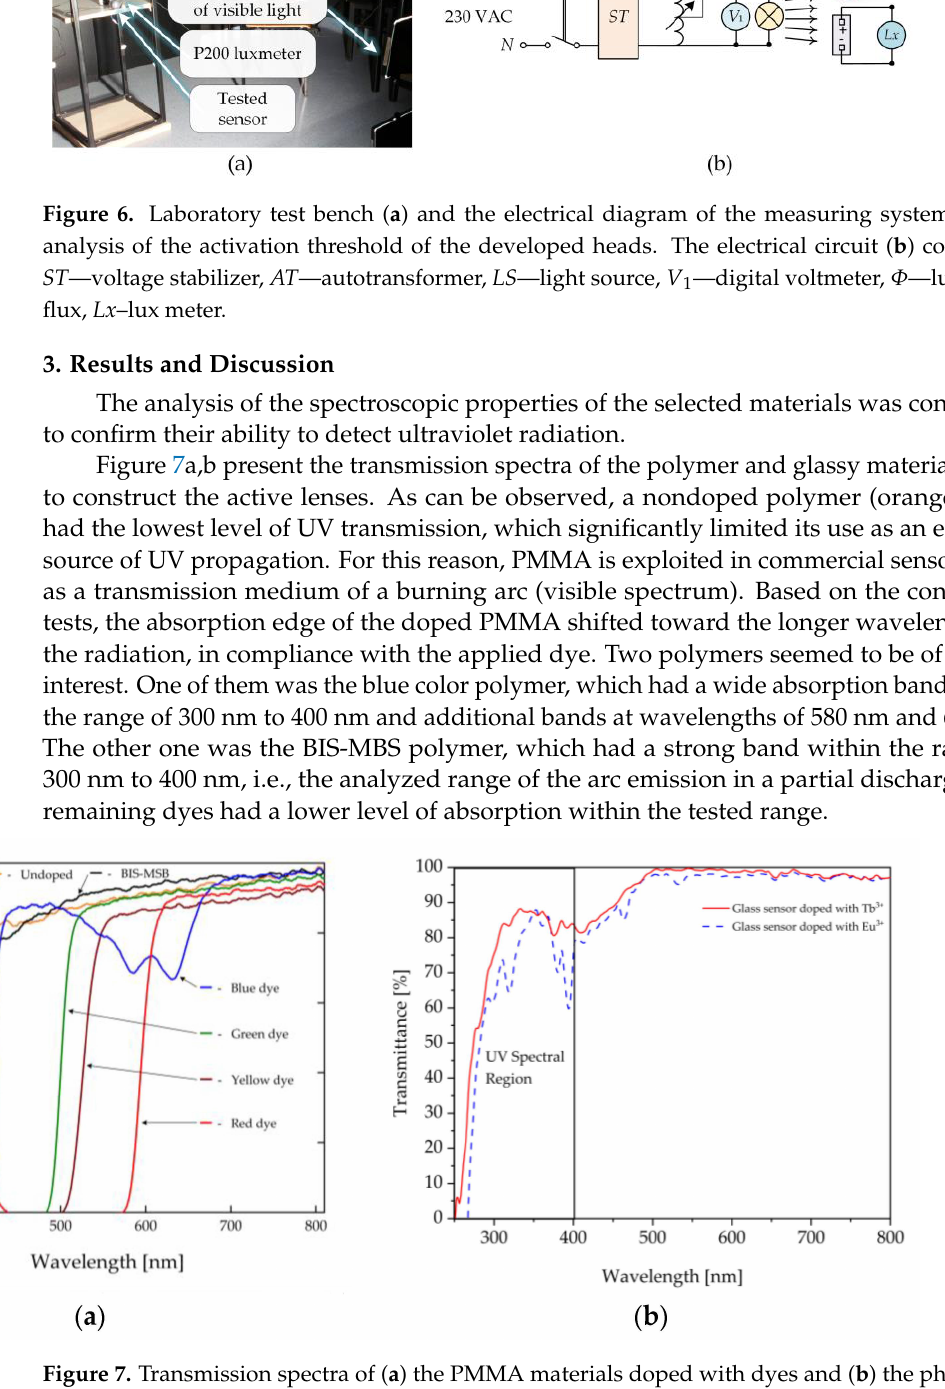
Figure 7. Transmission spectra of ( a ) the PMMA materials doped with dyes and ( b ) the phosphate glasses doped with Eu 3+ and Tb 3+ ions used in the sensor